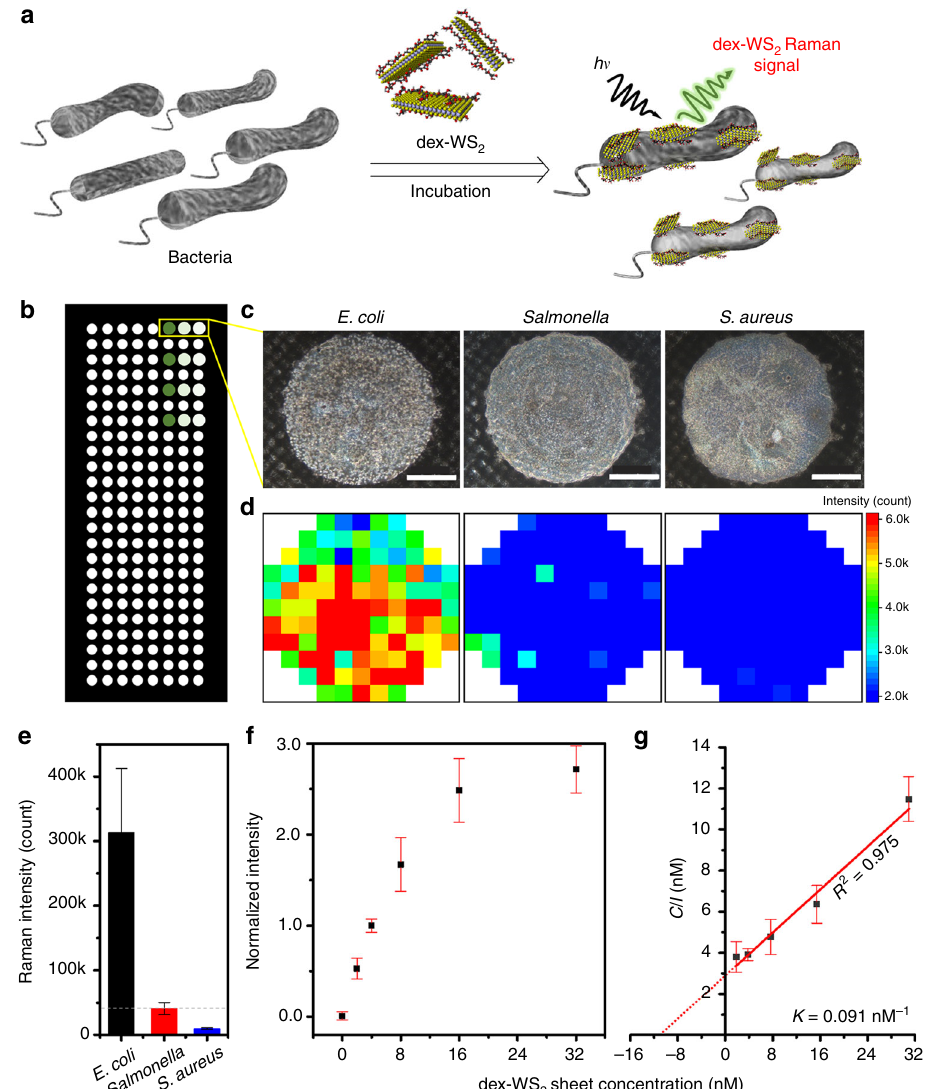
Fig. 5 Antibody-free optical detection of bacteria with dex-WS 2 . a Schematic illustration of the antibody-free optical detection of bacteria with dex-WS 2 . b Glass microarray and c Optical photographs of E. coli , Salmonella typhimurium , and S. aureus (2×10 6 CFU) treated with dex-WS 2 (25 μ g mL − 1 ) (scale bar, 500 μ m). d Raman images of the dex-WS 2 -treated bacteria based on the 2LA(M) peak of dex-WS 2 at 352 cm − 1 , showing the selective recognition of E. coli . e The total intensity of the Raman signal of dex-WS 2 bound on three different types of bacteria. f E. coli detection as a function of dex-WS 2 concentrations for the extraction of its af fi nity to E. coli . g Langmuir isotherm for the binding of dex-WS 2 to E. coli . All error bars represent a standard deviation from the mean values ( n =